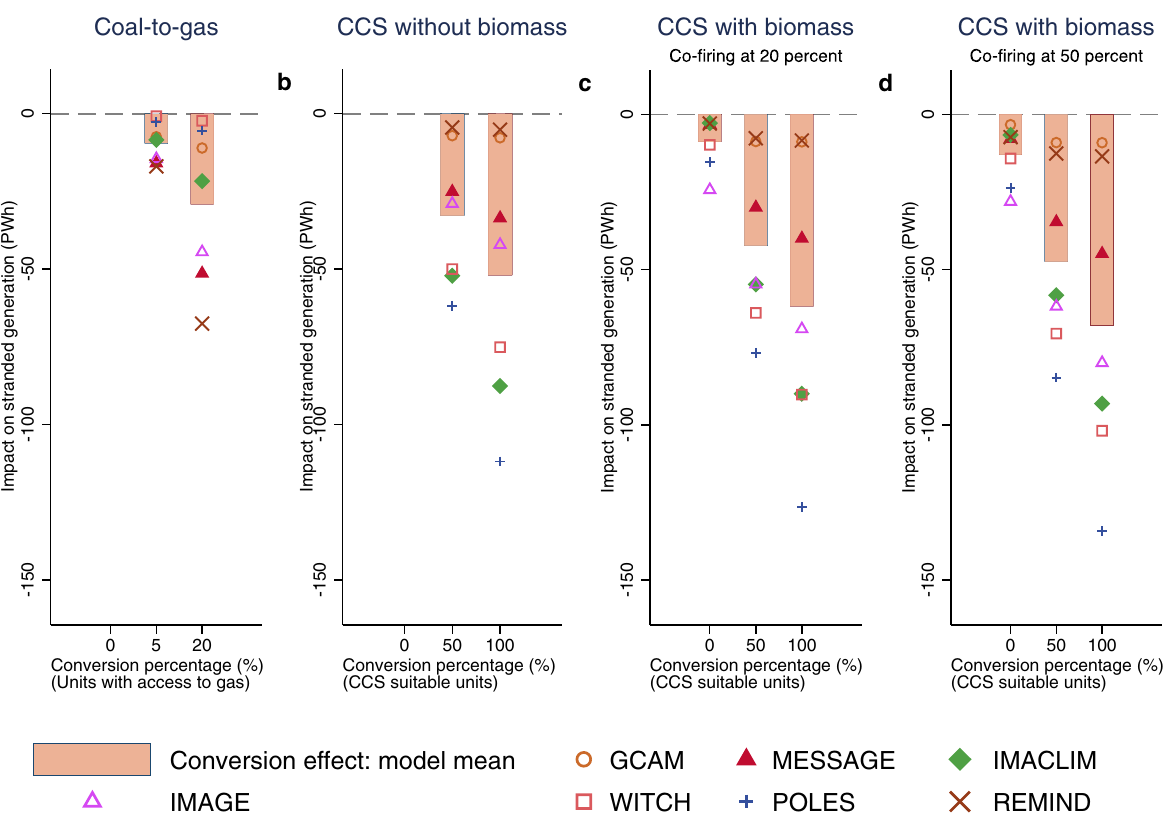
Fig. 3 Impact of plant conversions on global stranded generation. a Coal-to-gas, b carbon capture and storage (CCS) without biomass, c CCS with biomass co- fi ring at 20%, d CCS with biomass co- fi ring at 50%. Scatter points represent the estimation from individual models and bars show the model mean. The conversion percentages correspond to the share of coal- fi red power plants converted to gas. Those of b – d correspond to the share of CCS suitable plants converted to CCS. Biomass co- fi ring ratios vary from 0 in b to 50% in d